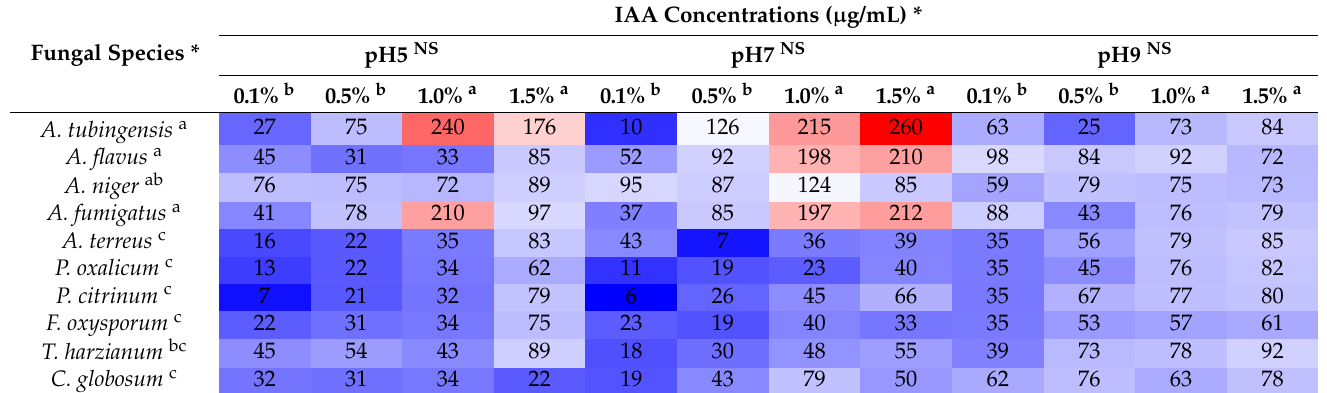
Color gradient (min: dark blue; max: dark red). For each factor, significant groups are labeled by superscripted letters. * p < 0.0001, NS = not